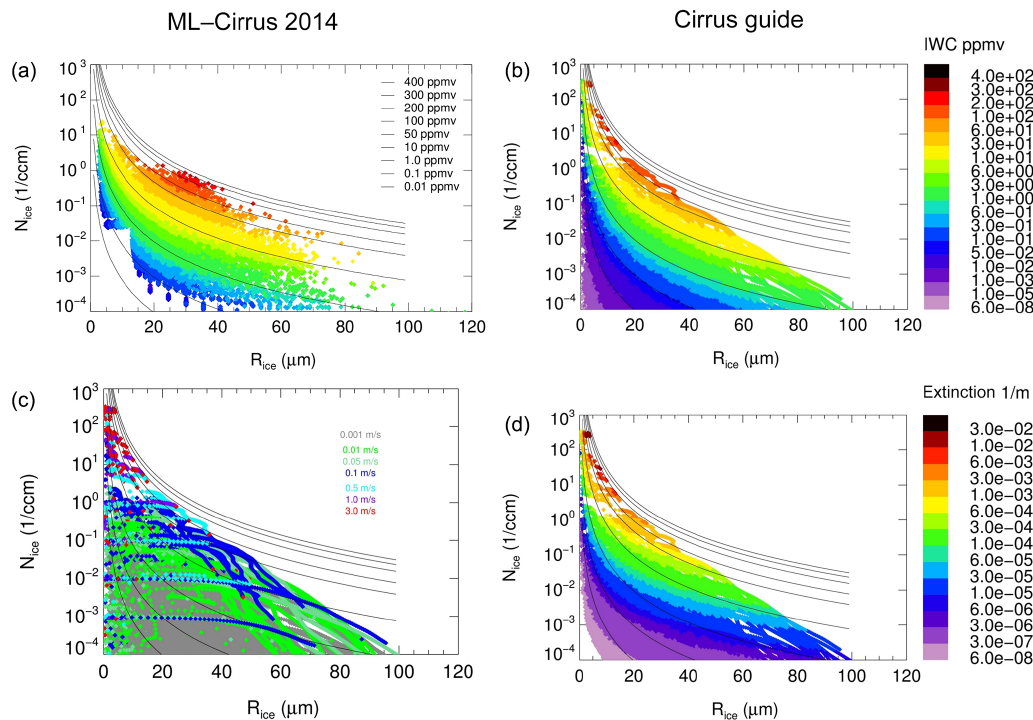
Figure 12. N ice vs. R ice . (a) Observations of in situ cirrus during ML-CIRRUS 2014 – color code IWC, black lines are IWC isolines. The other panels show the simulated Cirrus Guide: (b) color code IWC, (c) color code vertical velocity, (d) color code extinction. The simulations contain all scenarios including temperature fluctuations (“fluct”, see Sect.